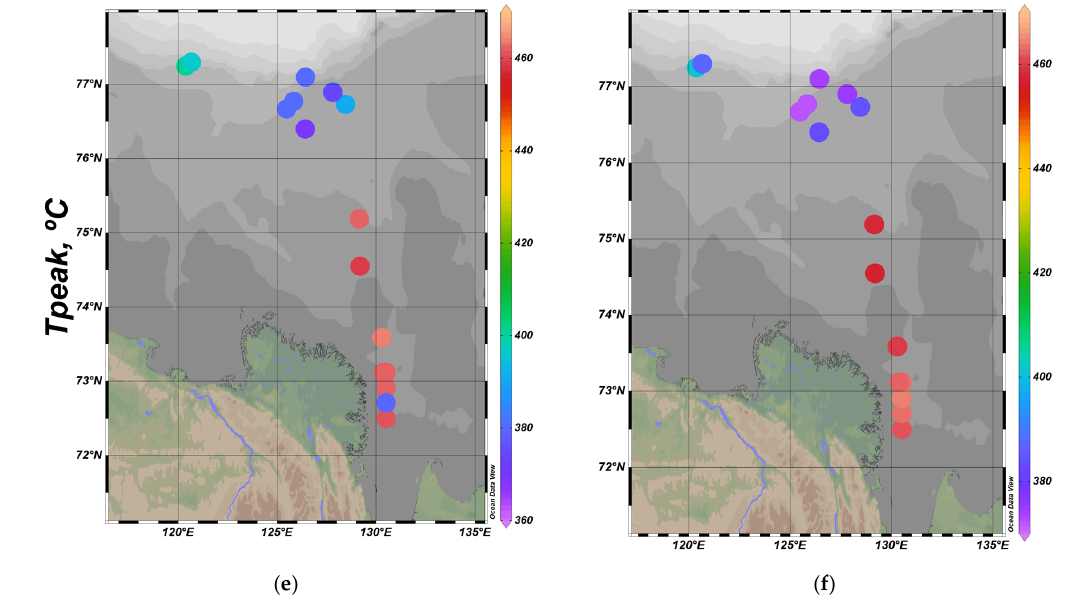
Figure 3. Distribution of Rock-Eval parameters for LS surface sediments: HI ( a , b ); OI ( c , d ) and T peak °C ( e , f ). Figure 3a,c,e show values for the uppermost sampling horizon 0–2 cm (for stations 6490, 6491, 6505, 6521 and 6527—0–5 cm); Figure 3b,d,f show values for the underlying sampling horizon 2–5 cm (for stations 6490 and